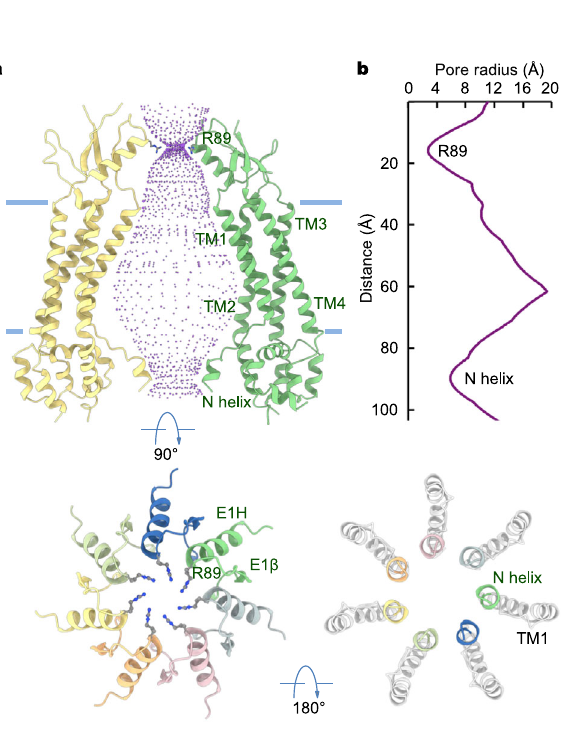
Fig. 3 | Ion conduction pore of PANX2. a The pore of PANX2The extracellular constriction formed by a ring of seven arginine amino acids (R89) from E1H is highlighted.Onlytwoopposingsubunitsareshowninthetoppanelforclarity.The extracellular and intracellular constrictions, which are de fi ned by R89 and the N-terminal helices, respectively, are highlighted in the bottom panels. b Pore dimension along the conduction path.